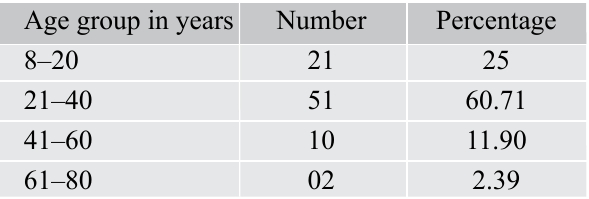
Table I: Distribution of subjects according to age (N=84)